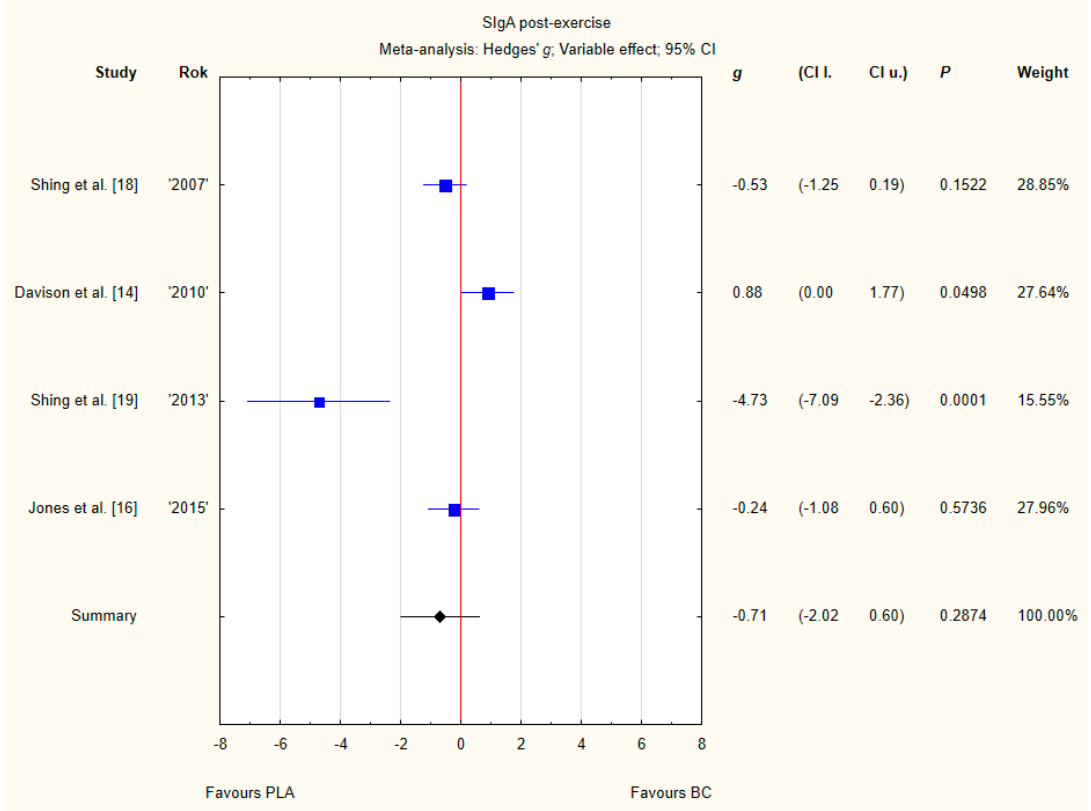
Figure 9. Forest plot of the random-effects meta-analysis of changes in post-exercise SIgA concentration. Heterogeneity: Tau 2 = 1.4; Chi 2 = 20.64; df = 3; I 2 = 85.47%; p = 0.0001. Abbreviations: BC–bovine colostrum, SIgA–secretory Immunoglobulin A,